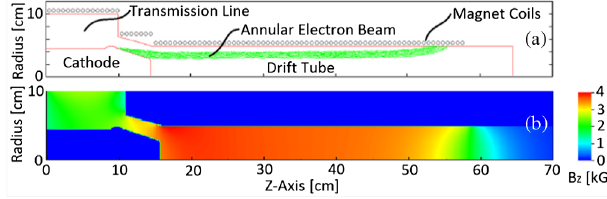
FIG. 1. Geometry (a) and magnetic field magnitude profile (b) for 2D simulations of the NLTL-based electron beam driver.